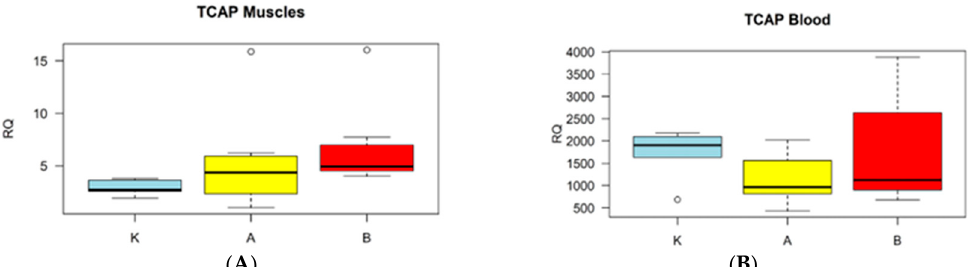
Figure 1. Comparison of the expression pattern of the TCAP gene between investigated tissues.